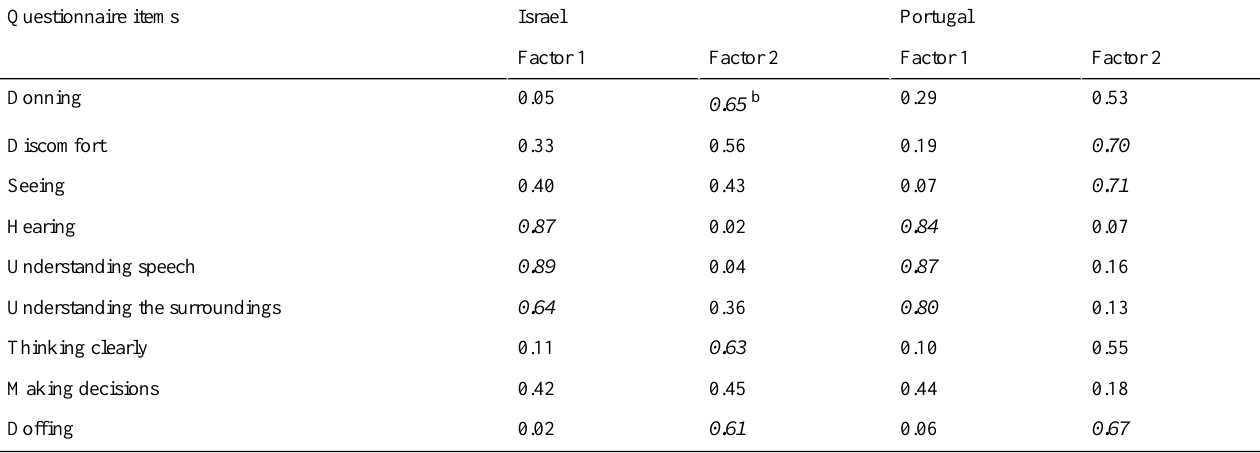
Table 3. Relative weights (loading coefficients) of all the questionnaire items according to the two factors identified for each country a . PortugalIsraelQuestionnaire items